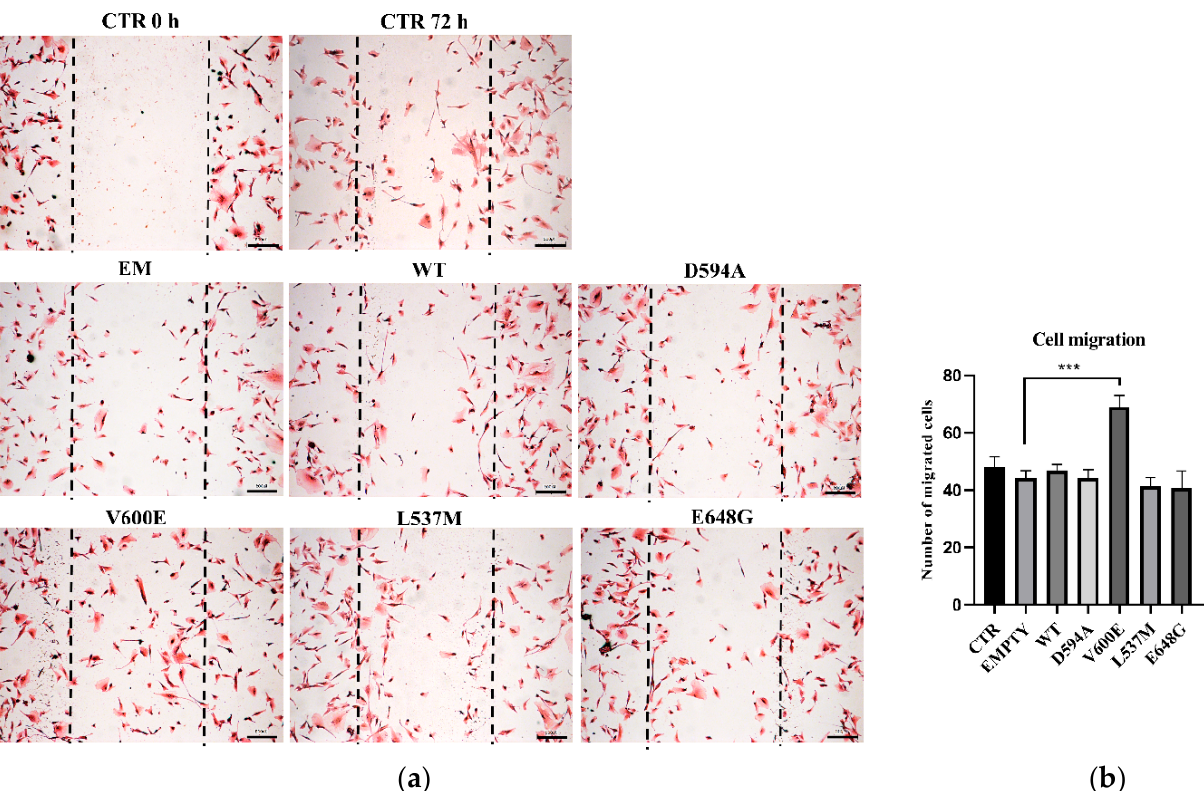
Figure 3. Cell migration assay on THLE-2 cells with overexpression of BRAF mutations. ( a ) Scratch assay picture of non-transfected (CTR) THLE-2 cells, transfected with BRAF wild type (WT), mutants (D594A, V600E, L537M, E648G), and empty plasmid (EM). Dark dashed lines indicate the trace of the wound front. Scale bar 200 μ m. ( b ) Bar chart with the number of migrated cells (±SEM) for all experimental groups, n = 3, *** p < 0.001. The statistical analysis was carried out using ANOVA with Bonferroni correction.